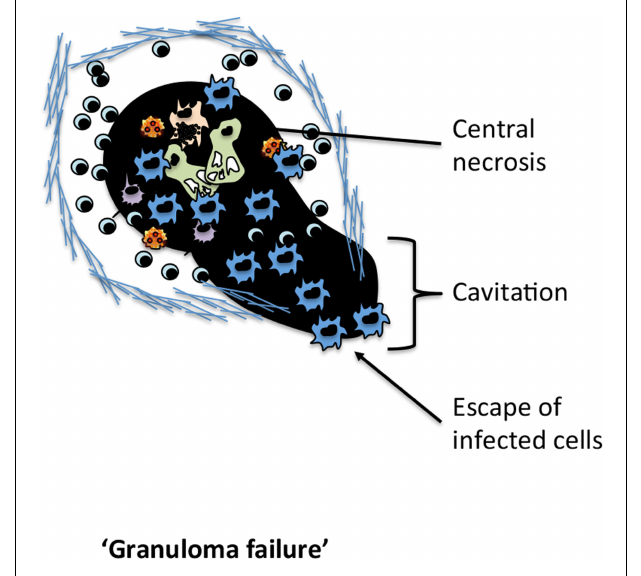
FIGURE 2 |The failure of theTB granuloma. The characteristic changes associated with the disintegration of theTB granuloma required for